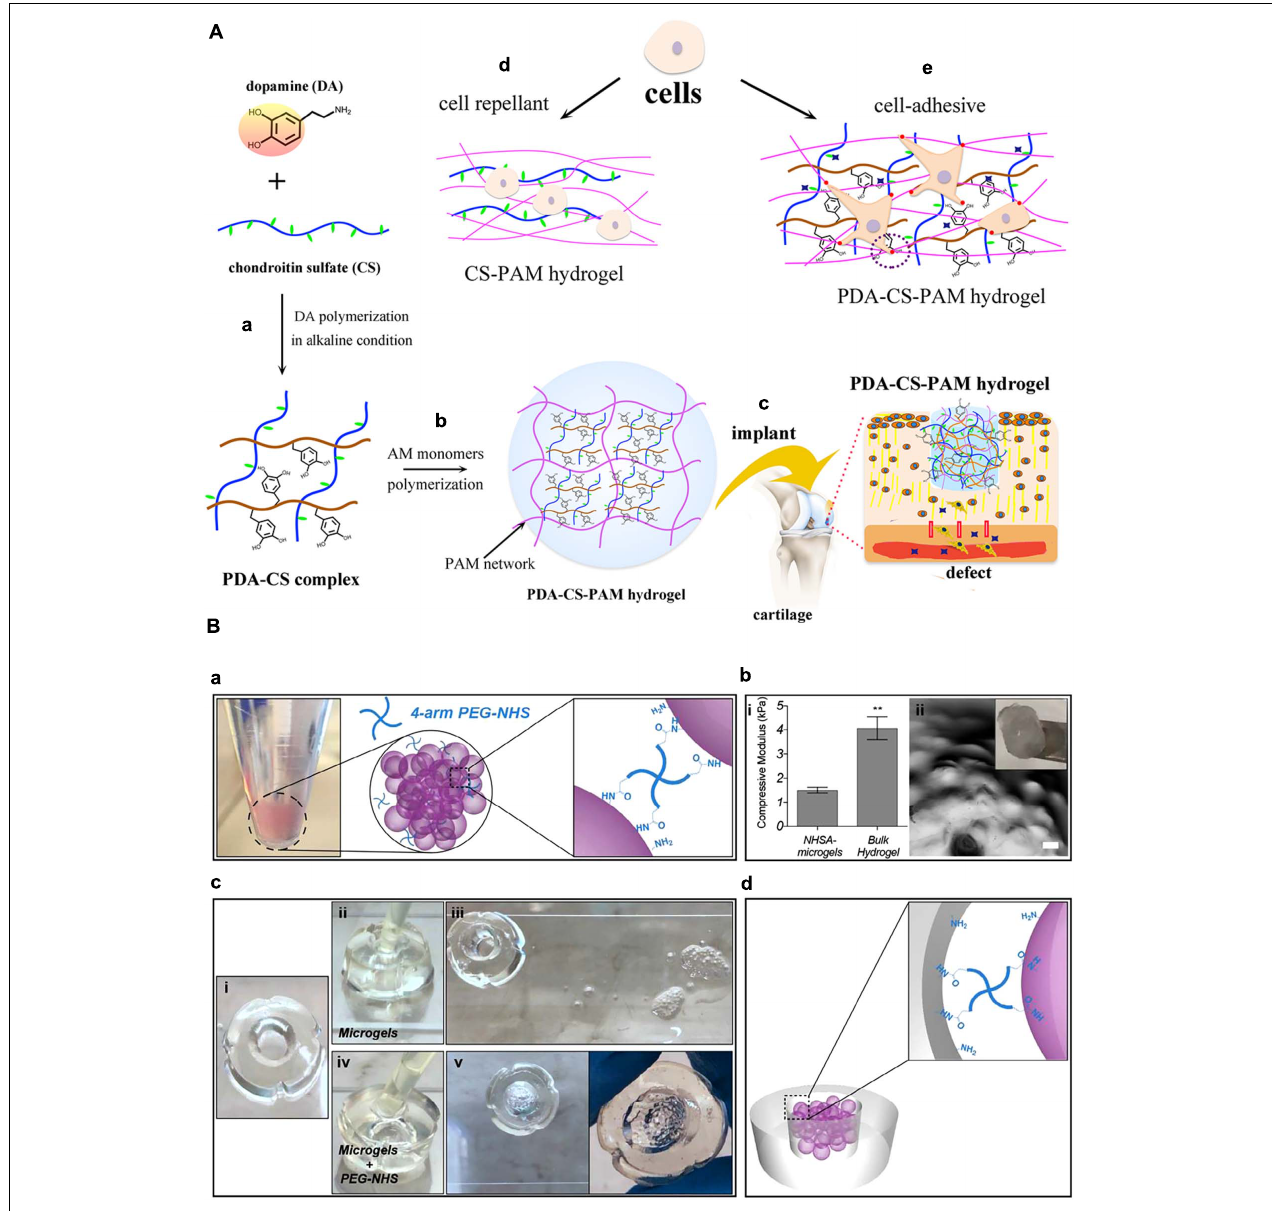
FIGURE 4 | Application of adhesive tissue engineering scaffolds (ATESs) in cartilage repair. (A) PDA-CS-PAM adhesive scaffold to regenerate cartilage. (a) Mechanism of PDA-CS complex fabrication. (b) Mechanism of PDA-CS-PAM hydrogel formation. (c) Schematic demonstration of the application of adhesive scaffold in vivo . (d) Cell repellence of CS-PAM hydrogel. (e) Promotion of cell adhesion to the hydrogel by addition of PDA. (B) Adhesive microgel systems for cartilage tissue engineering. (a) Assembly of microspheres induced by 4-arm PEG-NHS. (b) Assembled NHSA-microgels: (i) Compressive modulus of NHSA micro and bulk hydrogels by unconfined compression test; (ii) NHSA microgels on a spatula and under microscope (scale bar: 100 µ m). (c) In vitro testing of adhesion ability: ( i ) Hollow gelatin hydrogel; (ii,iii) Injection of untreated microgels into the middle of the hollow hydrogel and no adhesion after 90 min; (iv,v) Injection of PEG-NHS treated microgel suspension into the middle of the hollow hydrogel and adhesion after incubation. (d) Demonstration of adhesion mechanism between microgels and tissue. ** P < 0.01. Reconstructed with permissions from Fanyi et al. (2018) and Han et al.